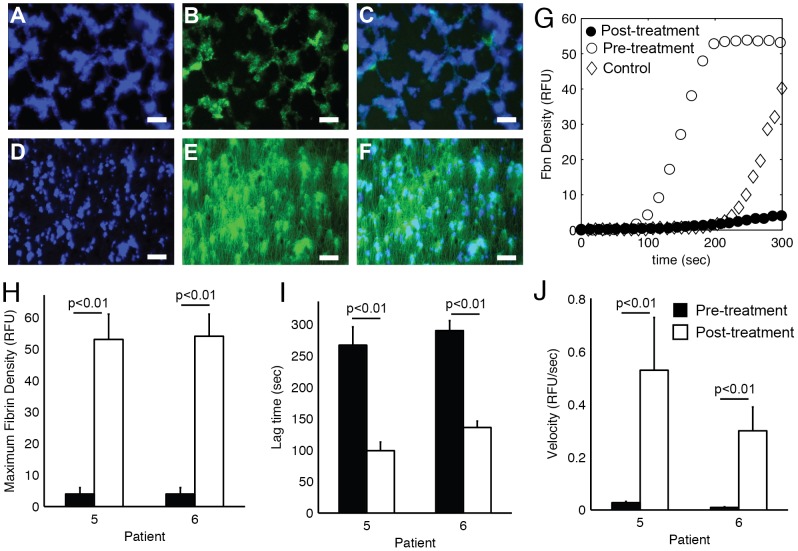
Fibrin deposition dynamics in response to rFVIIa treatment.Two patients (5–6) with severe FVIII deficiency with high inhibitor titer were treated with 90 µg/mL rFVIIa. Recalcified whole blood was perfused over glass slides coated with 2.3 fmol TF/cm2 and type 1 fibrillar collagen at 100 s−1 for 5 min before and 30 min after treatment with rFVIIa. Platelets (blue, anti-CD41), fibrin(ogen) (green, Alexa488-fibrinogen) and their overlay immediately before (A–C) and 30 min. after (D–F) rFVIIa injection. (G) Transient fibrin density pre-treatment (•) and post-treatment (○) in comparison to a normal control (◊). The dynamics of fibrin deposition before (black bars) and after (white bars) was characterized by (H) maximum fibrin density, (I) the lag time, and (J) the velocity. Error bars represent standard deviations of n = 3. Lines indicate comparisons between pairs according to the Mann-Whitney U-test.